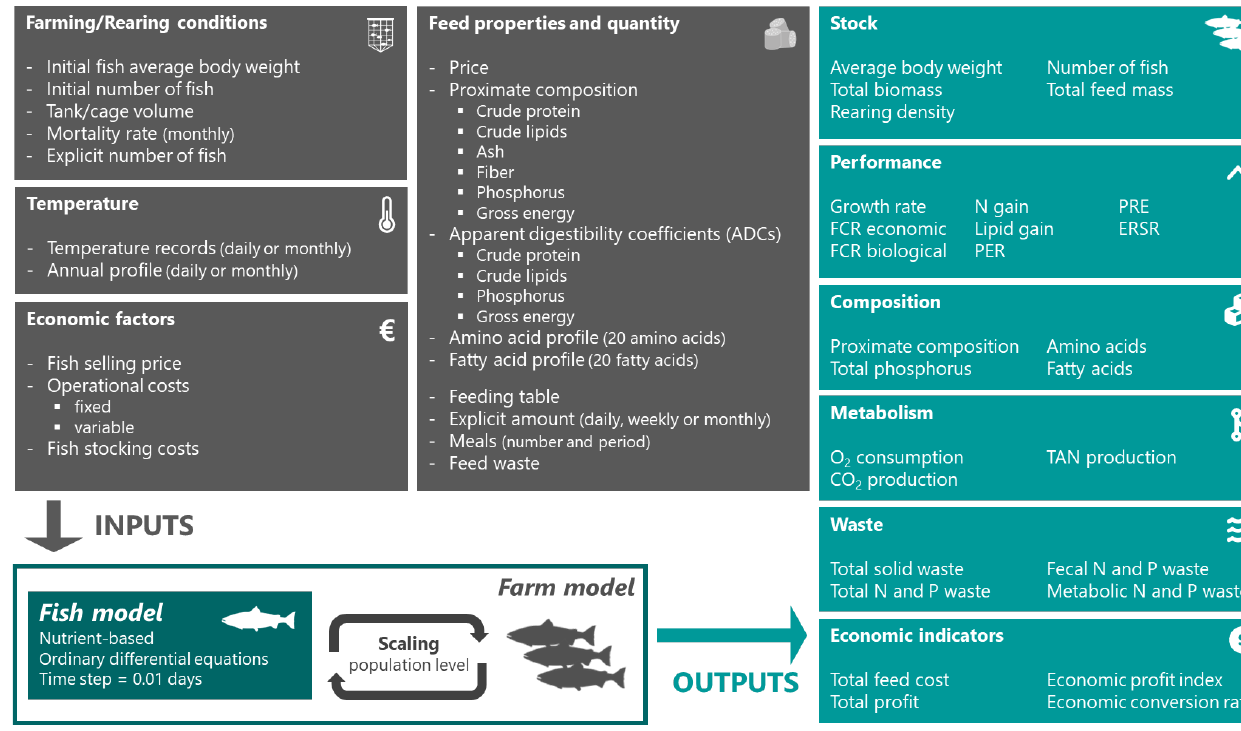
Figure 1. Diagram illustrating the main model inputs and outputs.